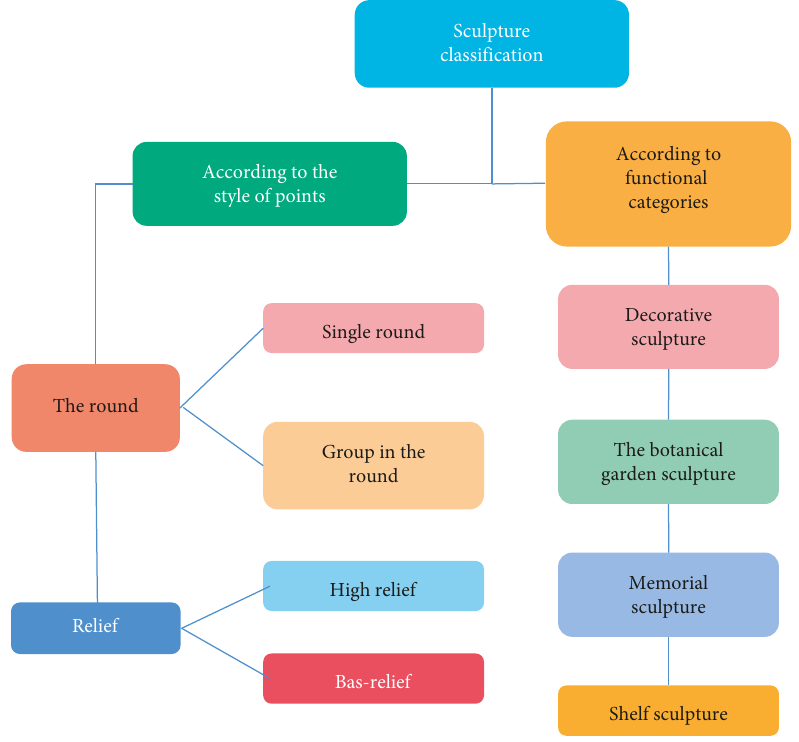
Figure 2: Basic types of